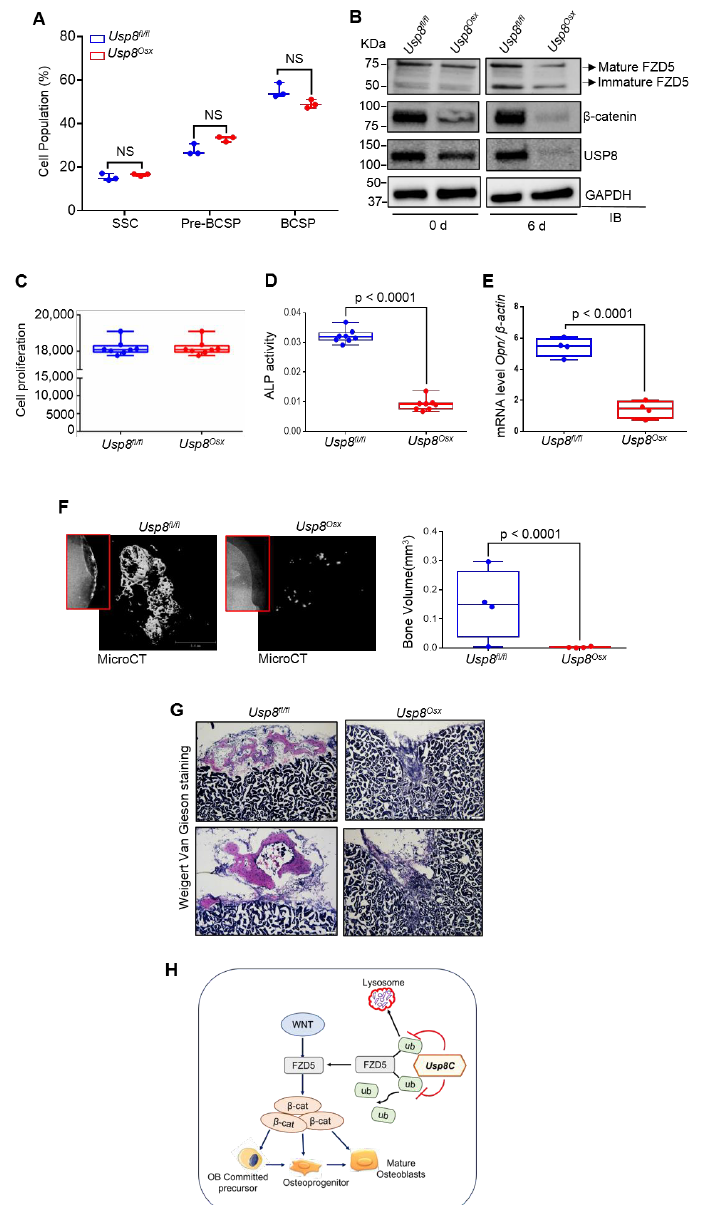
Figure 4. USP8 is essential for osteogenic differentiation of skeletal progenitors. ( A ) Quantification of flow cytometry on subpopulations of skeletal progenitors isolated from E18.5 Usp8 fl/fl